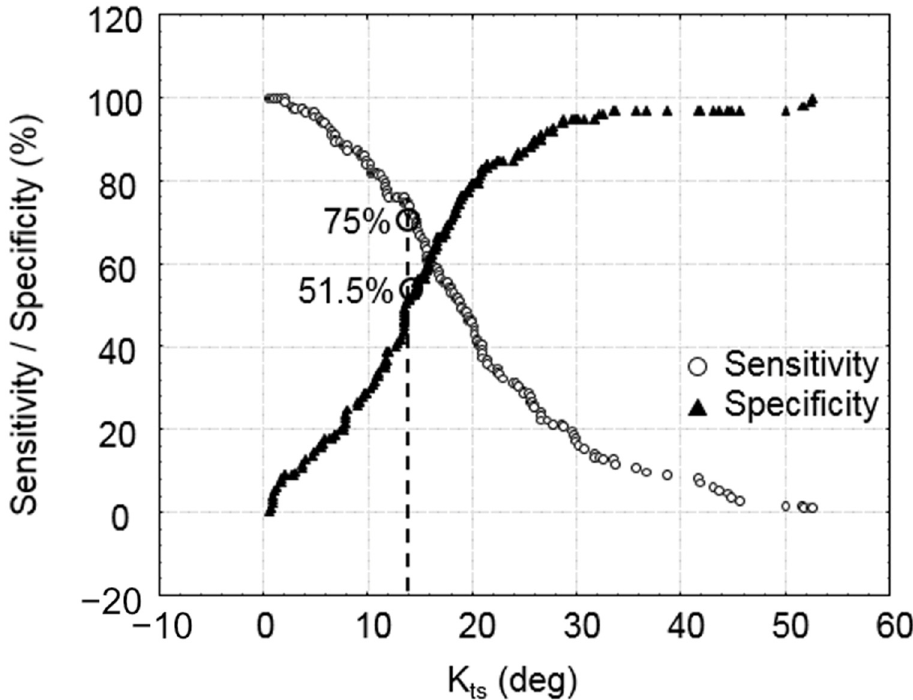
Figure 4. The results of ROC analysis (AUC = 0.66, p < 0.0001) indicate that the value of K ts = 13.93° generates the cutoff value (sensitivity = 75%, specificity = 51.5%) to detect the absence of knee flexors hypertonia. For K ts ≥ 13.93°, the probability of absence of hypertonia (as detected with TAS at fast velocities HYP vf ) decreases.